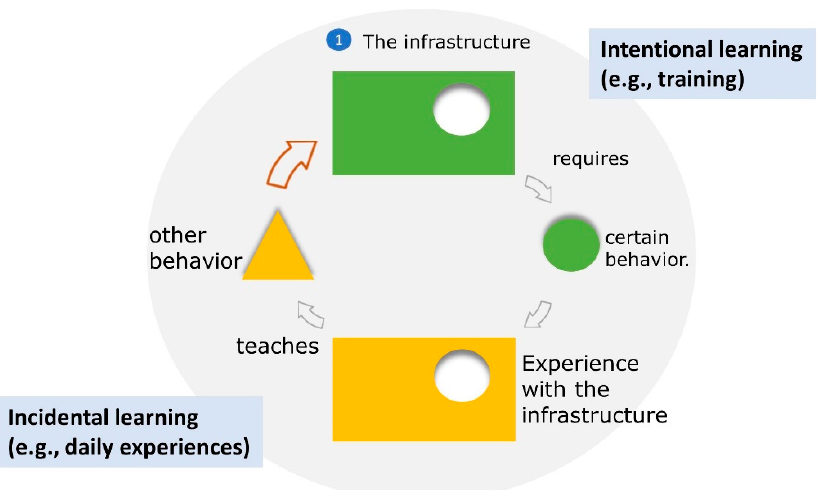
Figure 1. Differences during intentional and incidental learning can lead to human error despite thorough explicit training. Sections in green indicate an employee receiving explicit training on how he or she should perform according to company standards. The yellow sections indicate what an employee actually experiences on a day-to-day basis. If these differ, then human error can occur despite the employee successfully following the intentional learning sessions.